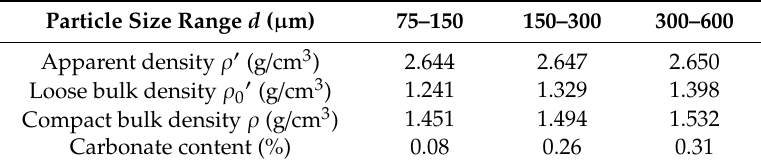
Table 1. The values of the physical indices of the quartz